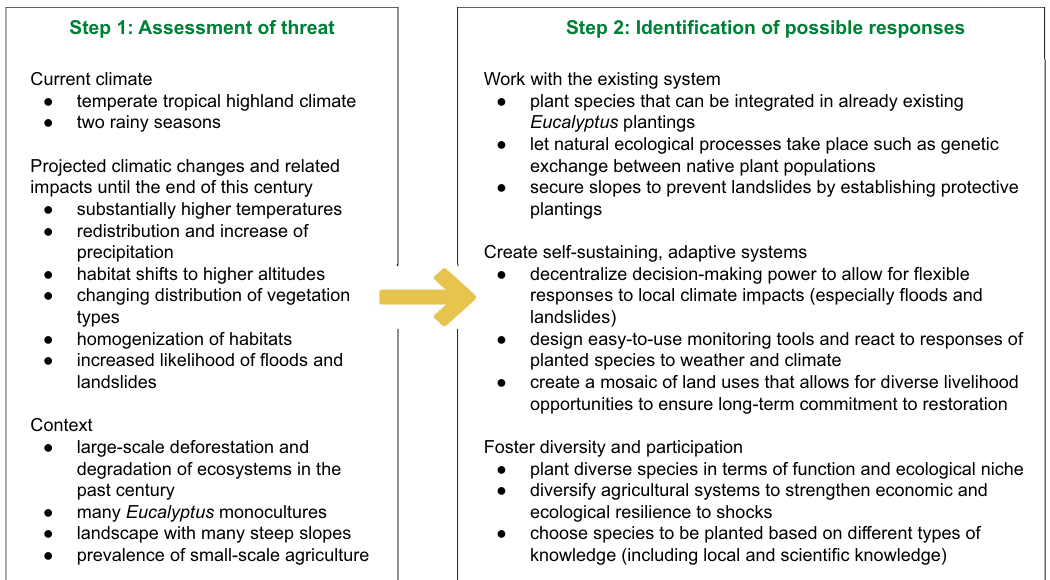
Fig. 3 Exemplary application of the three guiding themes to the threat of climate change in western Rwanda. In practice, the three guiding principles can be applied to any possible threat. Here, we apply it to effects of climate change on the Albertine Rift in western Rwanda. In a fi rst step, the current context and the effects of the focal threat need to be understood. In a second step, possible context-speci fi c responses based on the three guiding principles can be